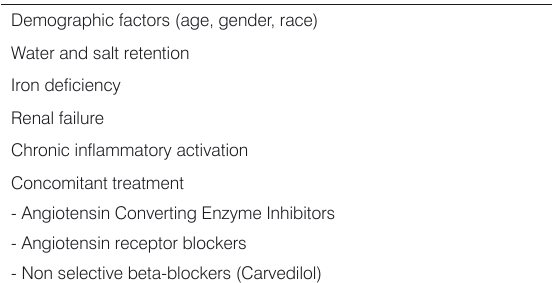
Table 2. Main factors related to anaemia in patients with heart